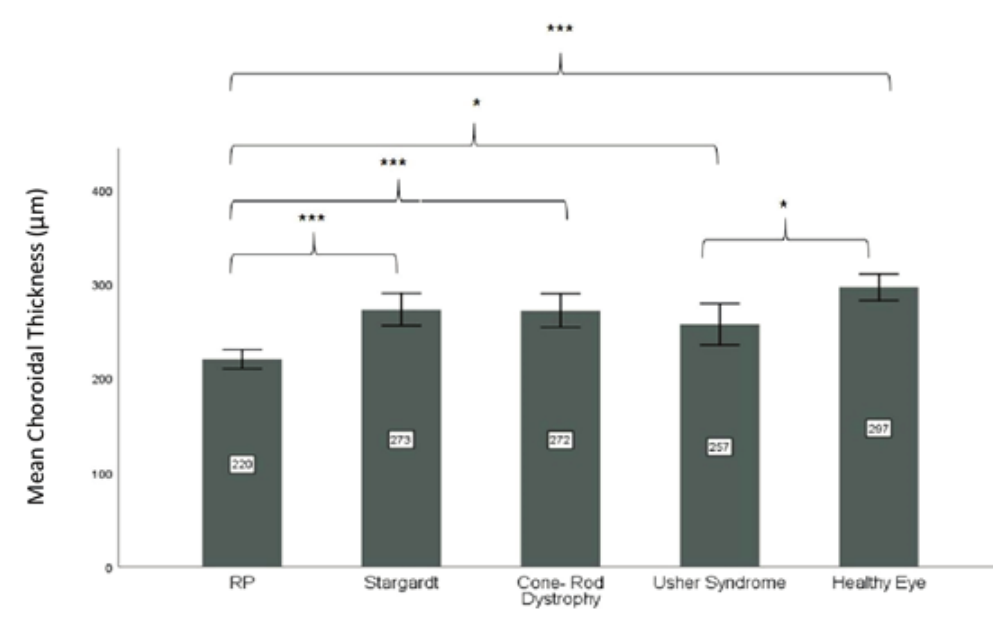
Figure 3. Mean total choroidal thickness (at 13 spots of measurement) in different types of inherited retinal dystrophies. RP, retinitis pigmentosa